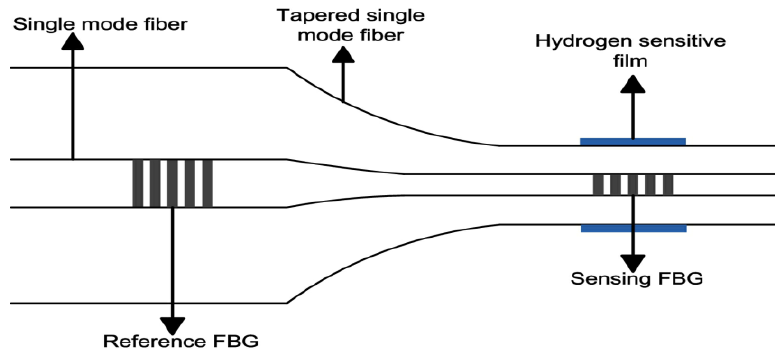
Figure 2. FBG hydrogen sensor based on a tapered single-mode fiber [18].